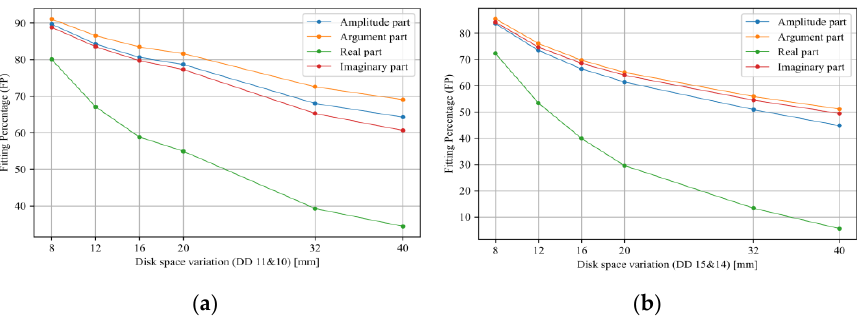
Figure 13. Feature variations based on the severity of the DSV fault in different locations for extracted by the FP index: ( a ) DSV in DD 11 and 10 ( b ) DSV in DD 15 and 14.